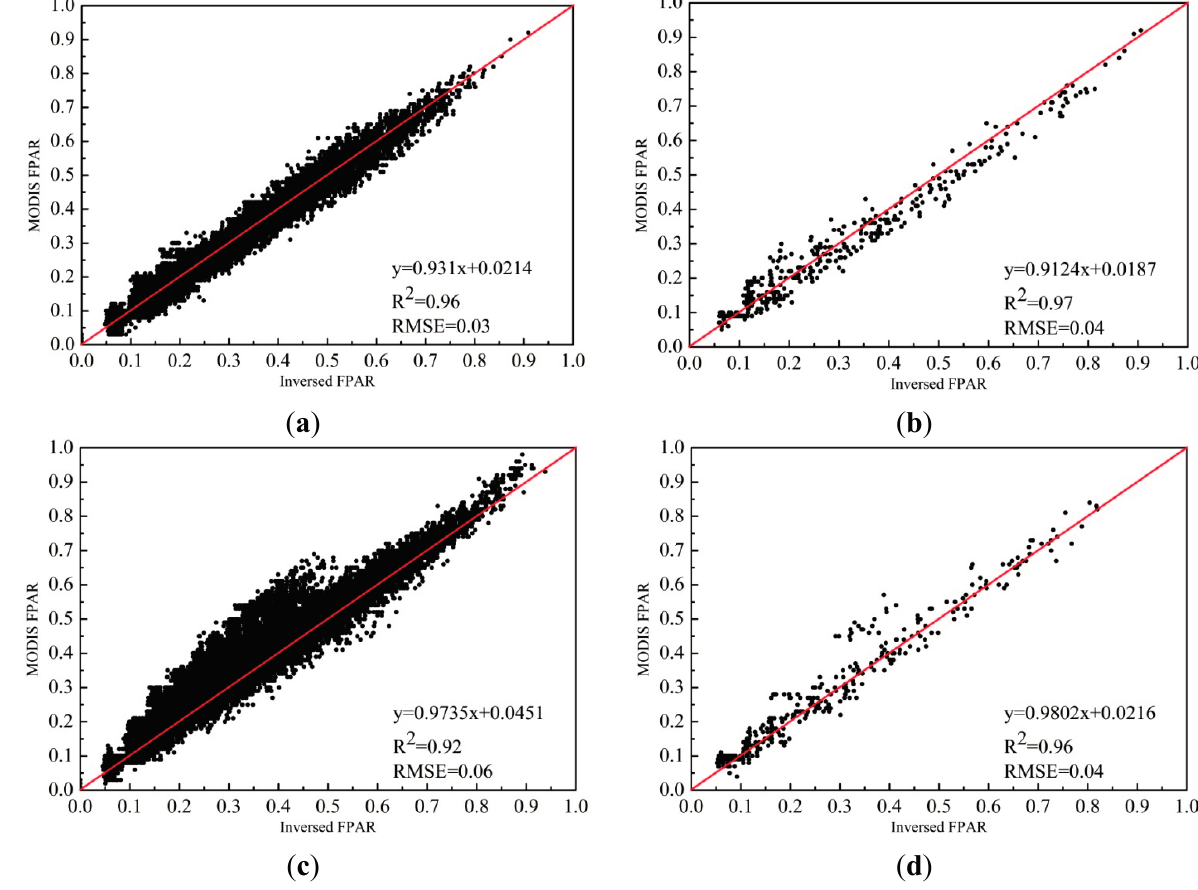
Figure 9. Scatterplots of inversion FPAR and MODIS FPAR for various vegetation types: ( a ) shrubs; ( b ) herbaceous; ( c ) evergreen needleleaf; ( d ) deciduous